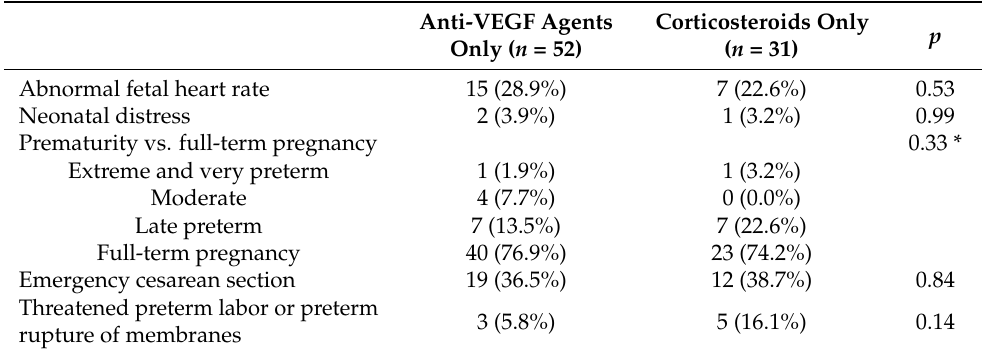
Table 5. Comparison of neonatal complications and pregnancy outcomes between women who had anti-VEGF IVTs only vs. women who had corticosteroid IVTs only during pregnancy or in the month preceding pregnancy, between 2013 and 2018 ( n = 83).